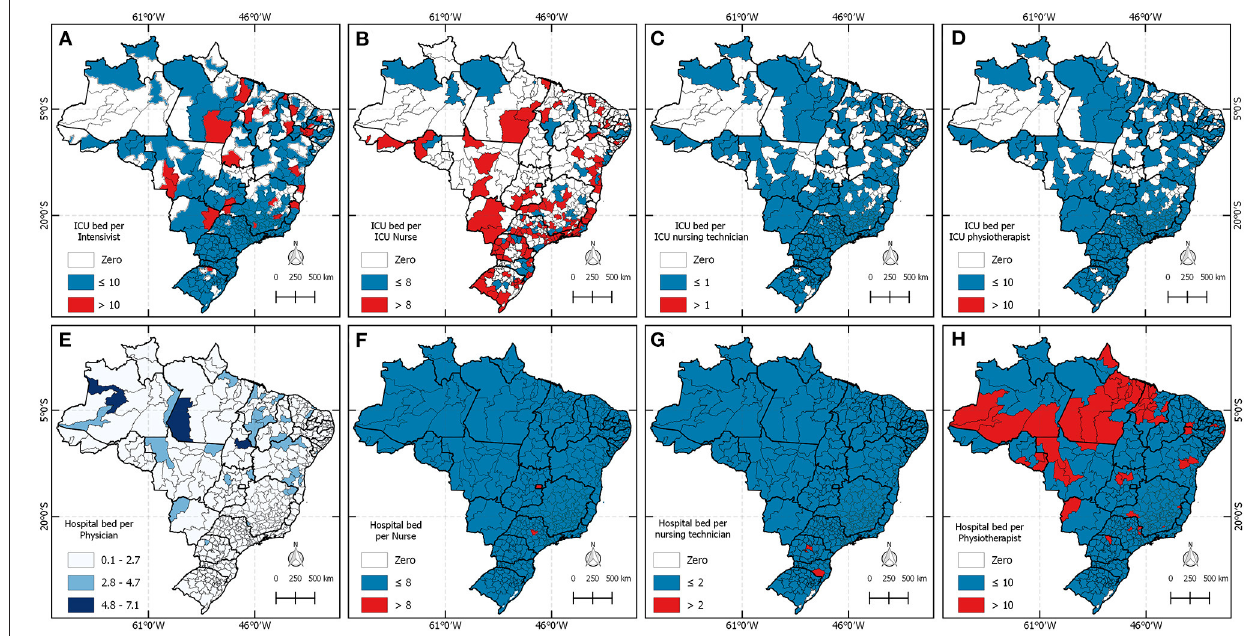
FIGURE 3 | Health regions in Brazil where the conditions of beds, equipment, and professionals are demonstrated according to ANVISA recommendations.